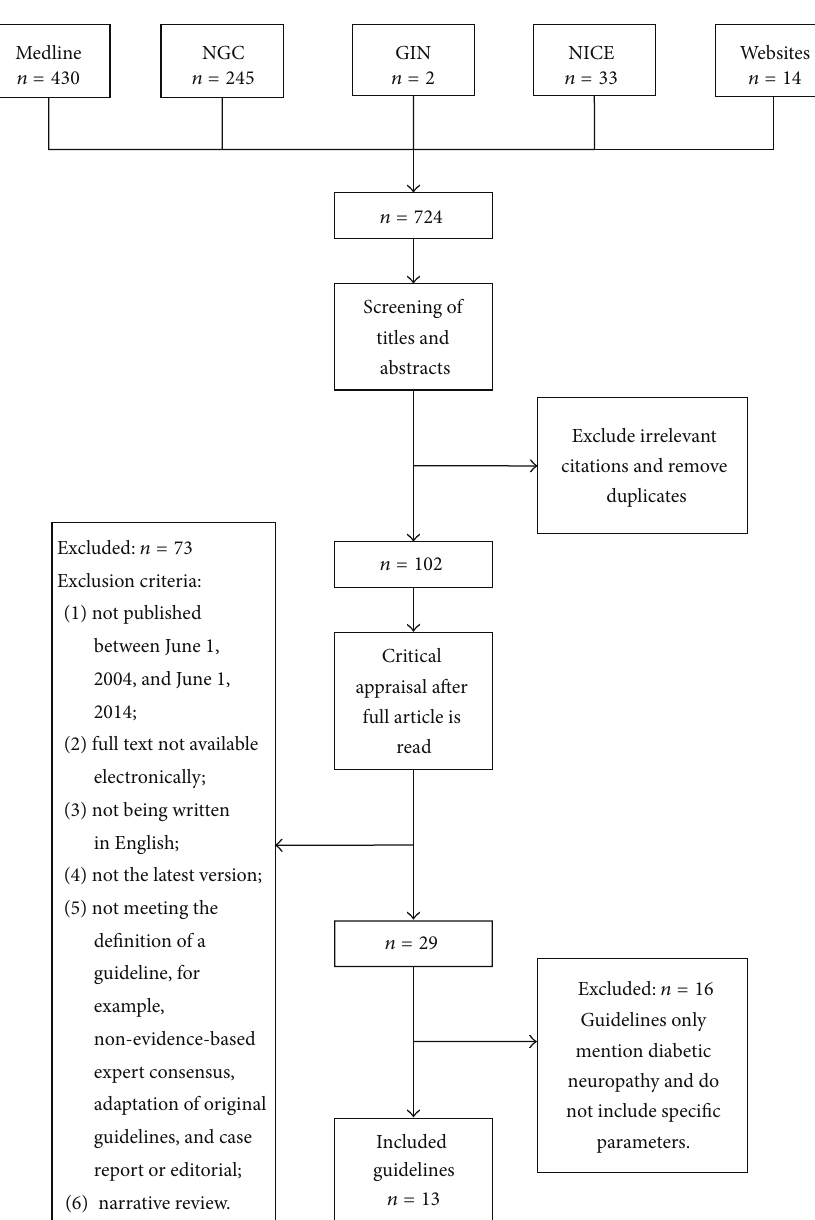
Figure 1: Search Strategies. “Medline” = Medline database; NGC = National Guideline Clearinghouse; GIN = Guidelines International Network; Websites = homepages of international medical societies and institutions or other relevant websites. NICE = National Institute for Health and Clinical